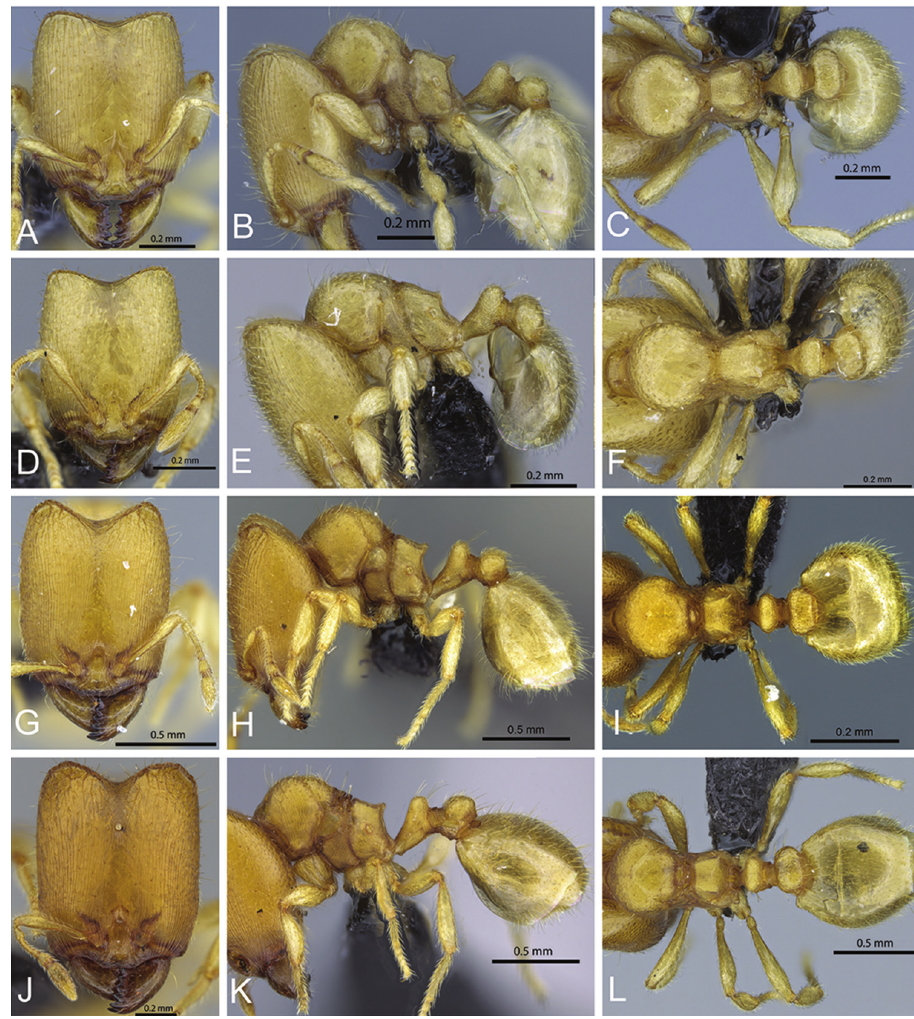
Figure 44. Intermediates of Carebara jajoby . Major workers, CASENT0496387: A head in full-face view B body in profile view C body in dorsal view. CASENT0068887: D head in full-face view E body in profile view F body in dorsal view. CASENT0037505: G head in full-face view H body in profile view I body in dorsal view. CASENT0070133: J head in full-face view K body in profile view L body in dorsal